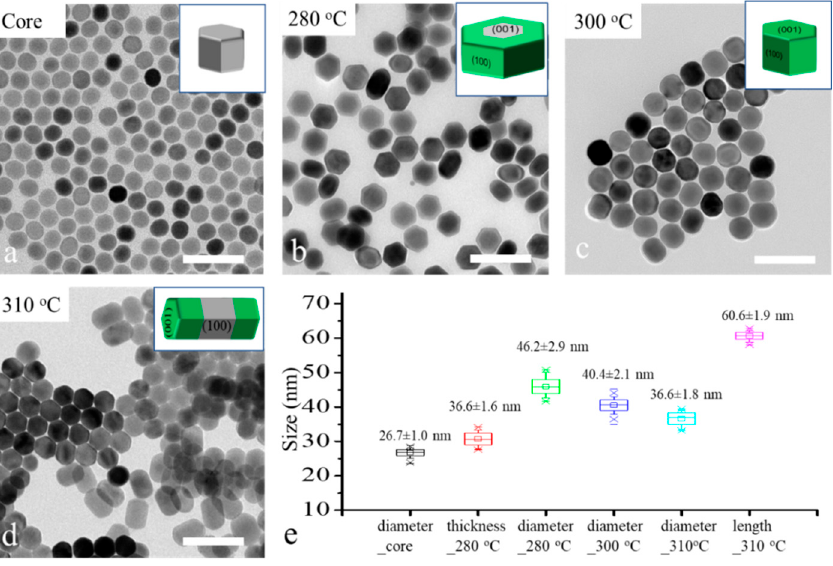
Figure 2. TEM images of core-only ( a ) and core–shell nanocrystals, synthesized at a different tem- perature, 280 °C ( b ), 300 °C ( c ) and 310 °C ( d ), and their statistical graph of size of core and core– temperature, 280 ◦ C ( b ), 300 ◦ C ( c ) and 310 ◦ C ( d ), and their statistical graph of size of core and shell nanocrystals. ( e ) All scale bar is 100 nm. core–shell nanocrystals. ( e ) All scale bar is 100